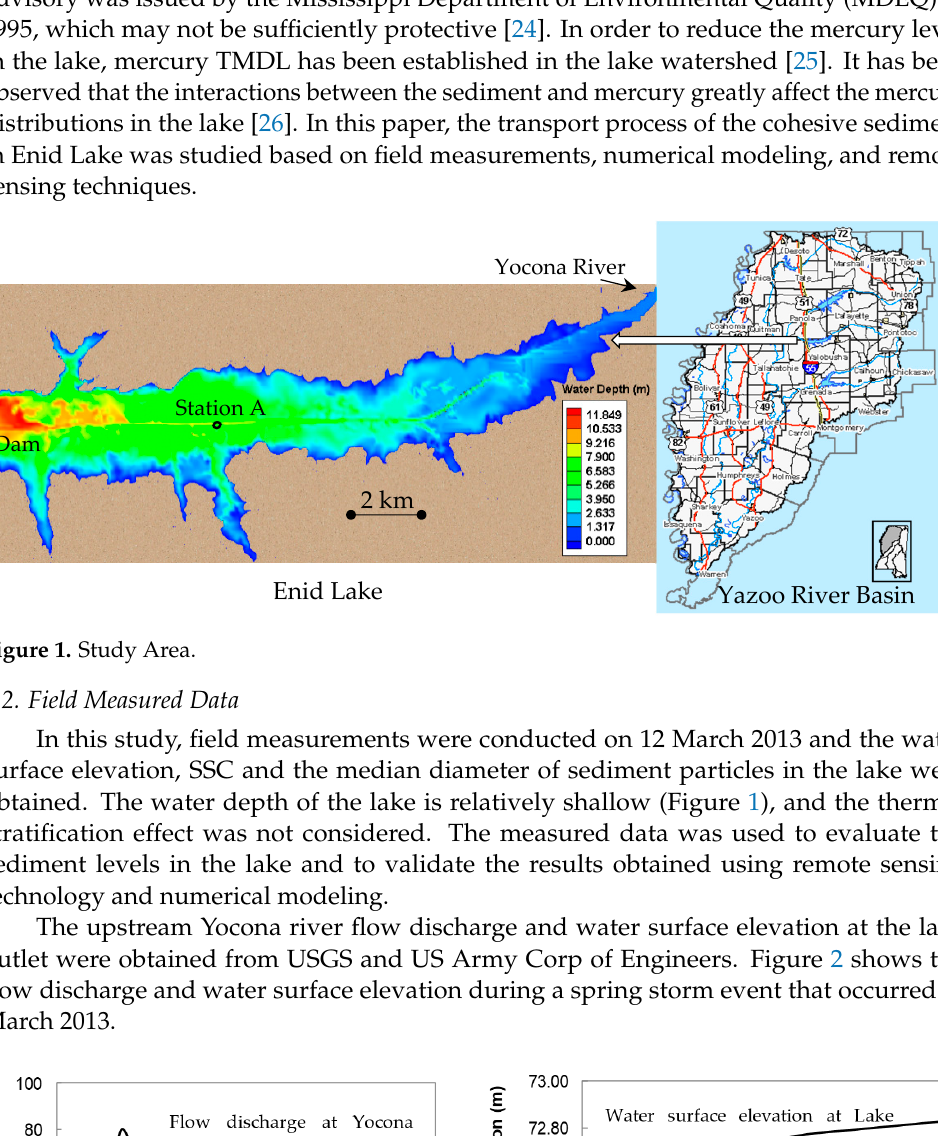
Figure 3. Wind speeds and directions near Enid Lake. 4.3. Remote Sensing-based Suspended Sediment Concentration Estimation Several studies had success in estimating total suspended sediment (TSS) using sim- ple linear regression techniques involving the MODIS visible and near-infrared (VNIR) bands and in situ measurements [6]. A similar approach was used in this study to estimate TSS in Enid Lake. The correlation coefficient of the regression equation was obtained us- ing near-real time in situ measurements of TSS and the reflectance values of the red (R) and near infra-red (NIR) bands of the MODIS (Band 1 and Band 2) imagery acquired on 12 March 2013. The measured datasets include 18 in situ samples. Figures 4 and 5 show the correlation between the MODIS Reflectance of Red and NIR Bands (Band 1 and Band 2) and the TSS for 12 March 2013. Day (March 10-18, 2013) 10